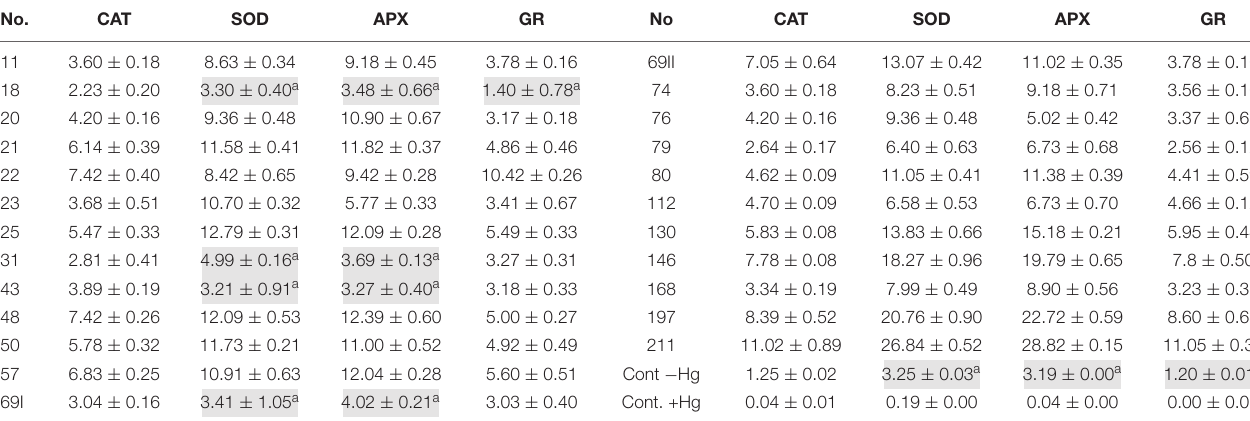
TABLE 3 | The mean values of replicates ( n = 5) ± SD for the antioxidant enzymatic activity (enzyme mg Prot − 1 min − 1 ) in the presence of PGPB treatments and controls (absence of Hg and presence of Hg). No.